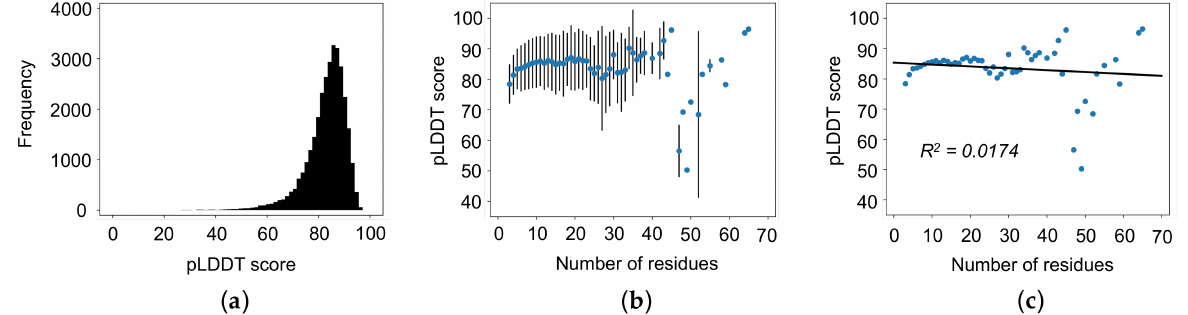
Figure 6. pLDDT scores of AlphaFold 2 predicted structures. ( a ) pLDDT scores of all loop regions. ( b ) Average pLDDT scores as a function of the number of residues in a loop with standard error bars. ( c ) Average pLDDT scores as a function of the number of residues in a loop with linear regression (R 2 = 0.0174). pLDDT scores are not correlated with the number of residues in the loop regions.